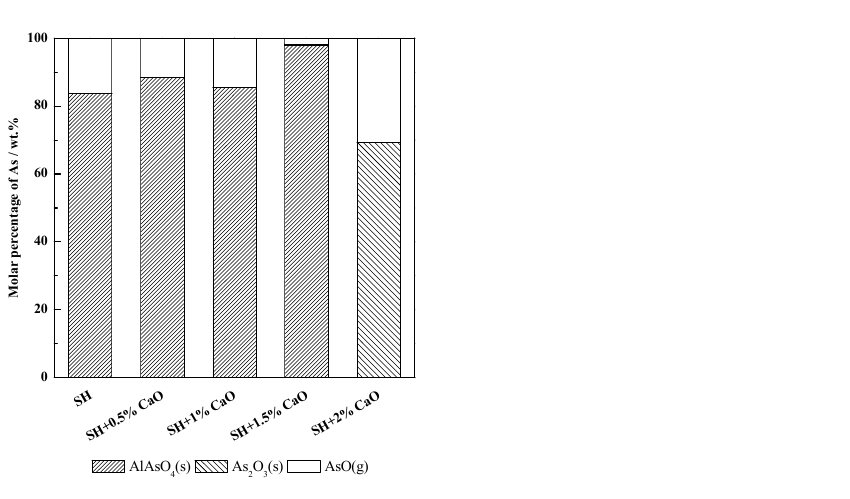
Figure 1. The influence of the addition of CaO on the distribution of arsenic under 1100 °C.